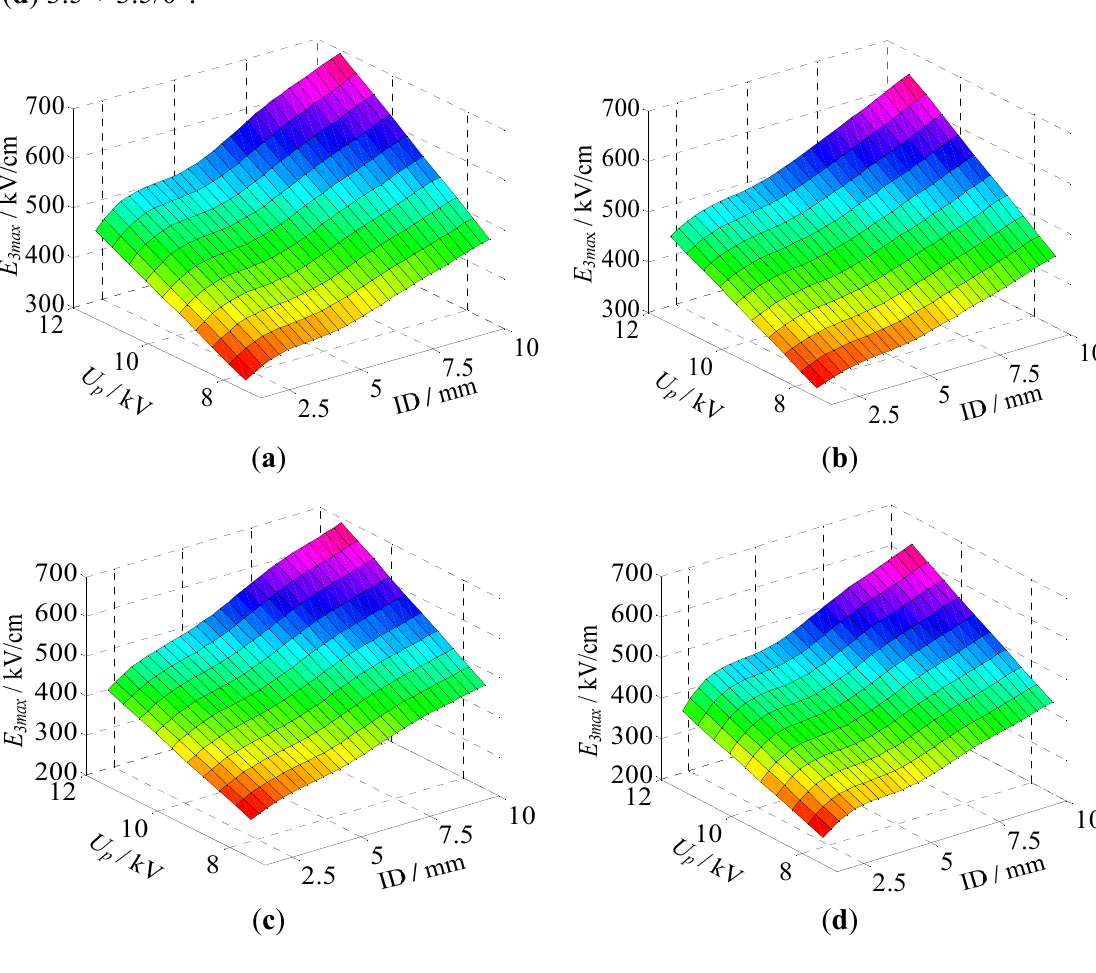
Figure 10. E obtained using COMSOL as a function of applied voltage and ID for 3 max different configurations (NL/INRA): ( a ) 3.5 + 2/45°; ( b ) 3.5 + 2/0°; ( c ) 3.5 + 3.5/45°; ( d ) 3.5 +